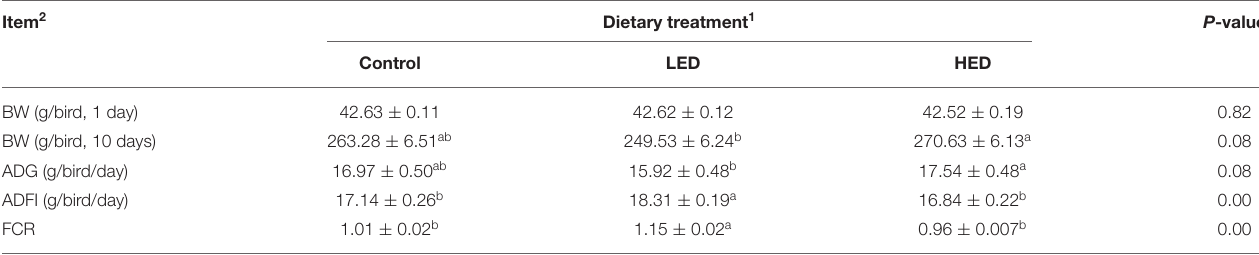
TABLE 3 | Effects of dietary energy levels on the performance of 10-day-old broiler chickens.